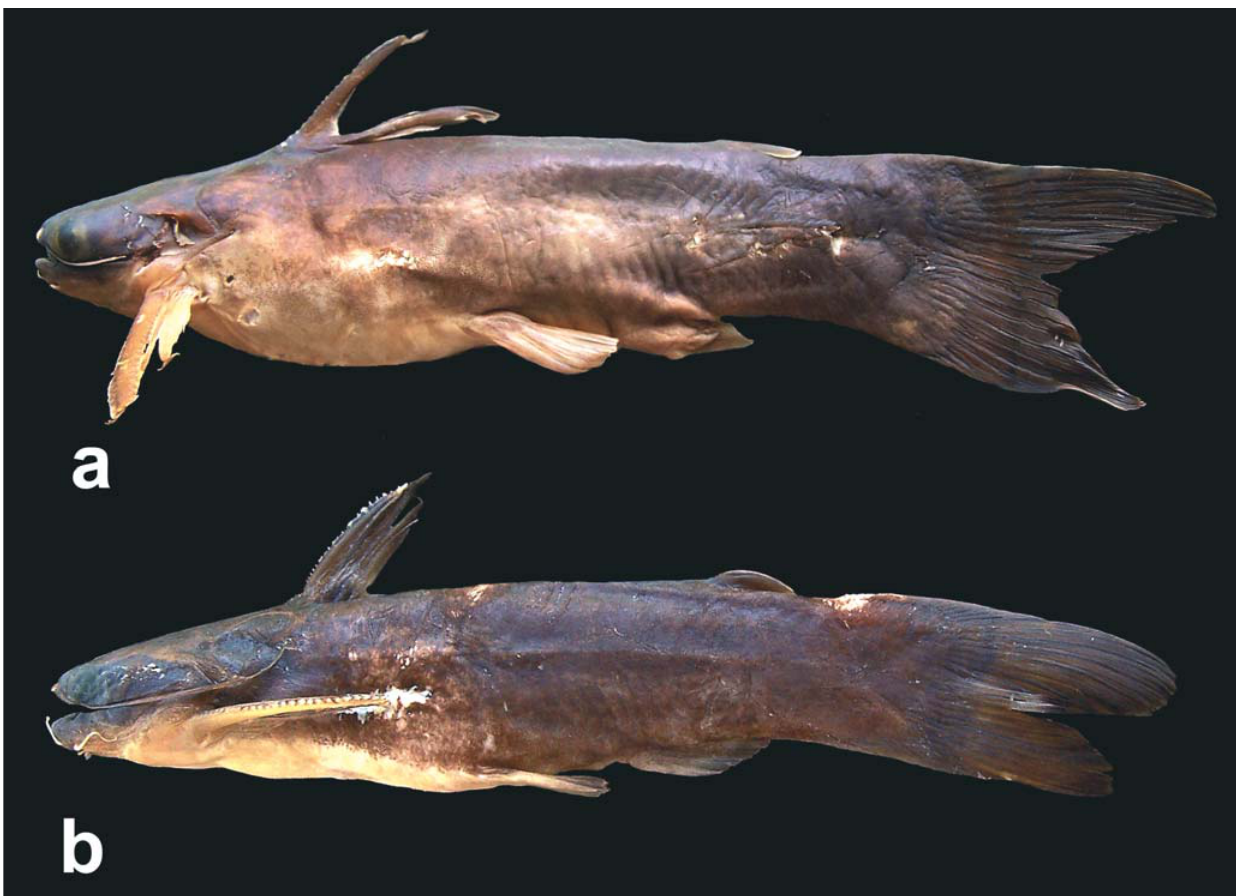
Fig. 36. Tatia nigra. (a) holotype, INPA 12291, male, 116.8 mm SL. (b) paratype, INPA 25501, female, 107.3 mm SL, Uatumã river, Amazonas State,